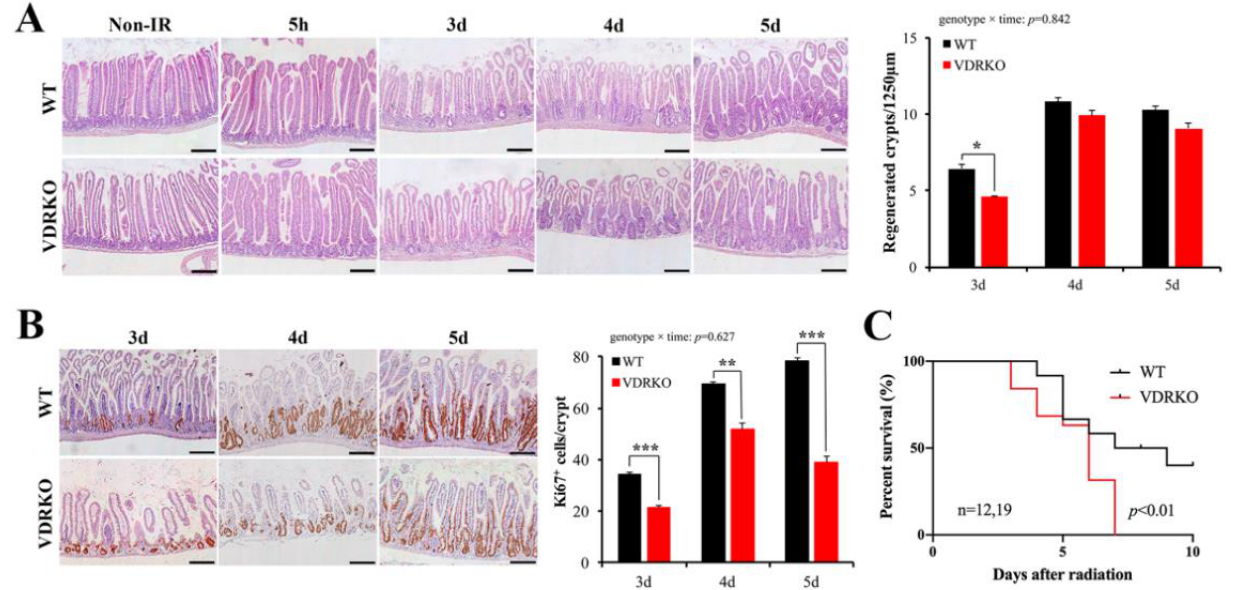
Figure 4. VDR deficiency suppresses intestinal epithelial regeneration and survival time of mice following IR. ( A ) Repre- sentative H&E images of intestine of WT and VDRKO mice at different times of 0, 5 h, 3 d (days), 4 d and 5 d after 12 Gy IR. Quantitative analysis of the number of regenerated crypts/1250 µ m at different times after IR. n = 6 in each group. ( B ) Representative IHC staining of the expression of Ki67 of WT and VDRKO mice and quantification of Ki67 + cells/crypt at different times after IR. n = 6 in each group. Values are means ± SD. * p < 0.05, ** p < 0.01, *** p < 0.001. Scale bar, 200 µ m. ( C ) Kaplan–Meier survival analysis of mice subjected to 12 Gy IR. The statistical analysis was performed by log-rank test. n ≥ 12 in each group.